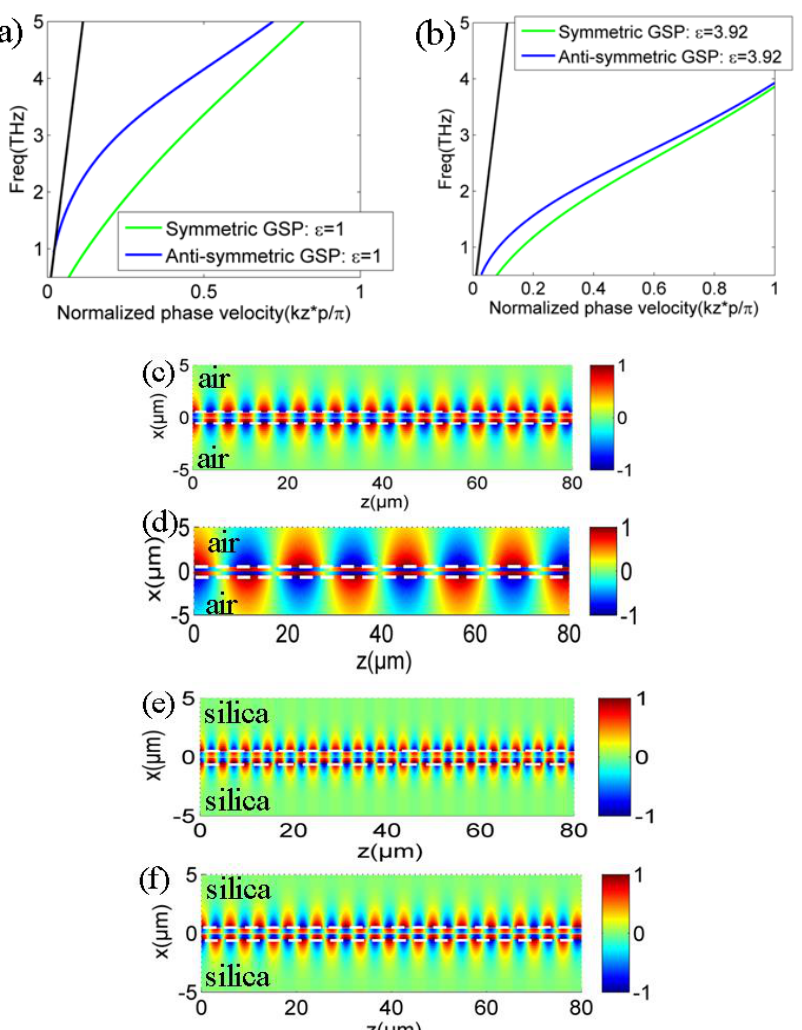
Figure 4. ( a , b ) are the GSP dispersion lines on double-layer graphene metasurfaces with dielectric ε = 1 (air) and ε = 3.92 (silica) conditions in Figure 1. ( c , d ) are the symmetric and antisymmetric GSP mode patterns with ε = 1 (air) condition, respectively. ( e , f ) are the corresponding GSP modes with ε = 3.92 (silica), respectively. Operation frequency is at 2 THz and other parameters are given in